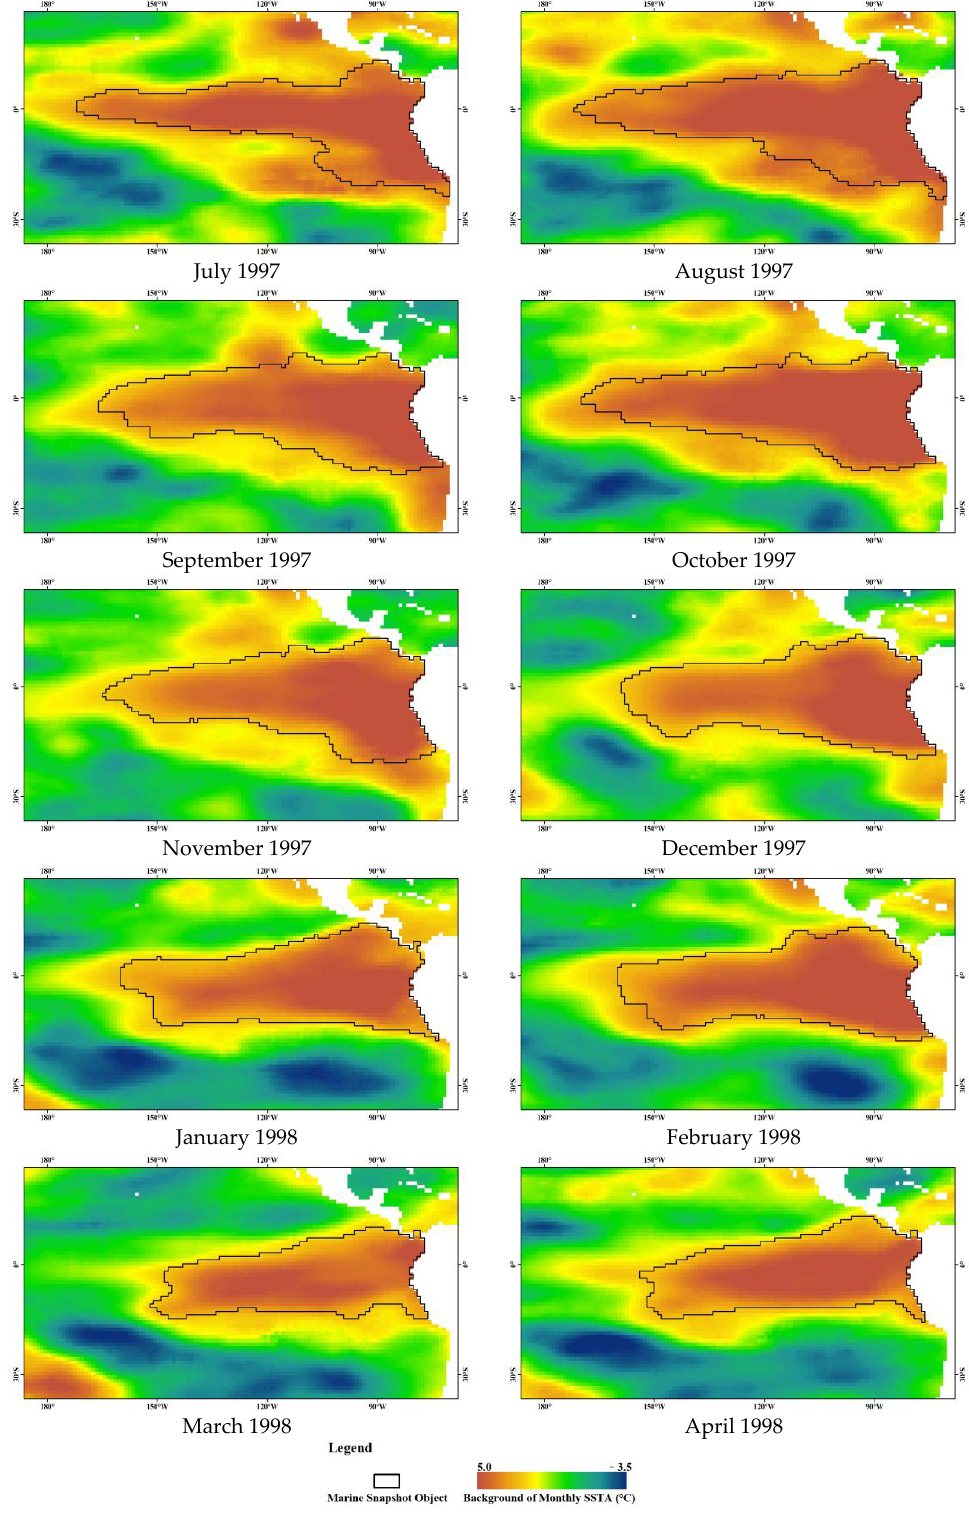
Figure 10. Sequence object 3 develops in the Equatorial Eastern Pacific Ocean from July 1997 to April 1998. The background is the monthly SSTA.